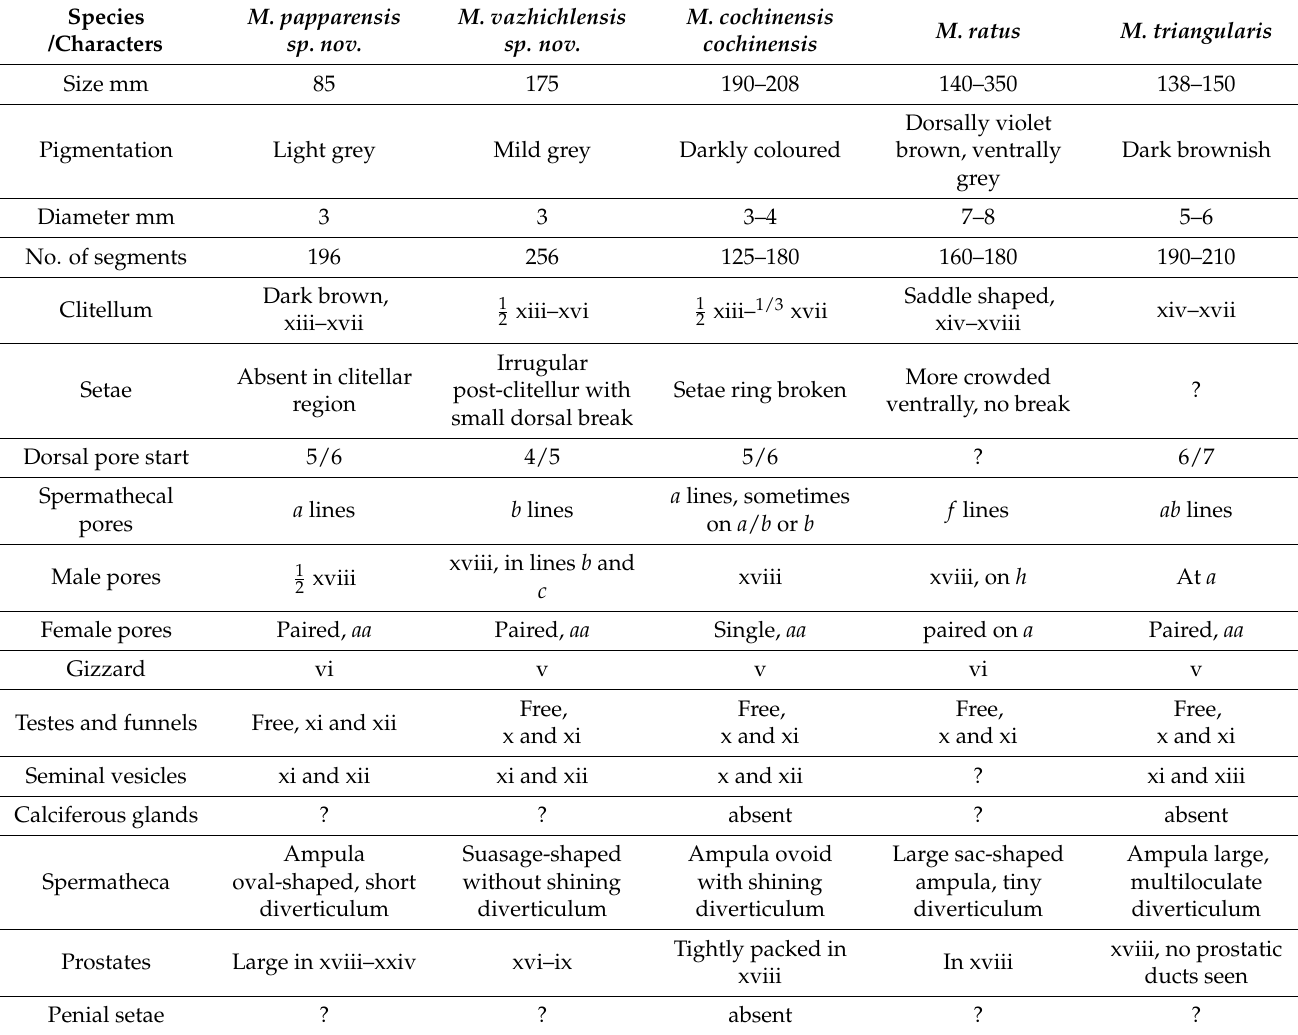
Table 1. Comparative account of morphological characters of selected Megascolex species which belong to different clades in phylogenetic